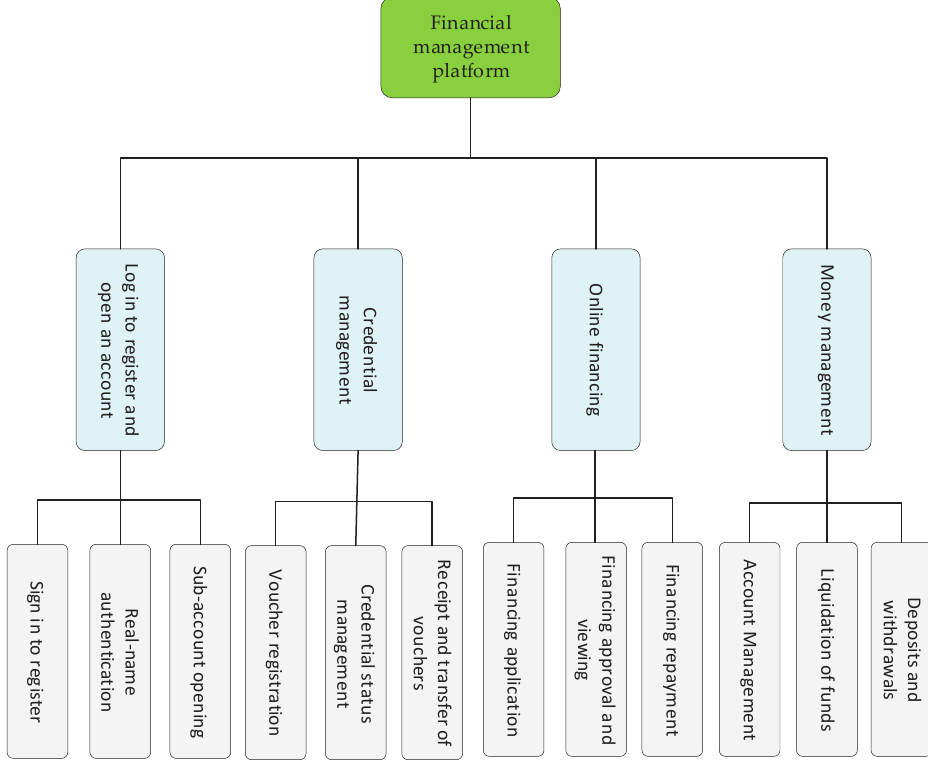
Figure 1. General diagram of system function